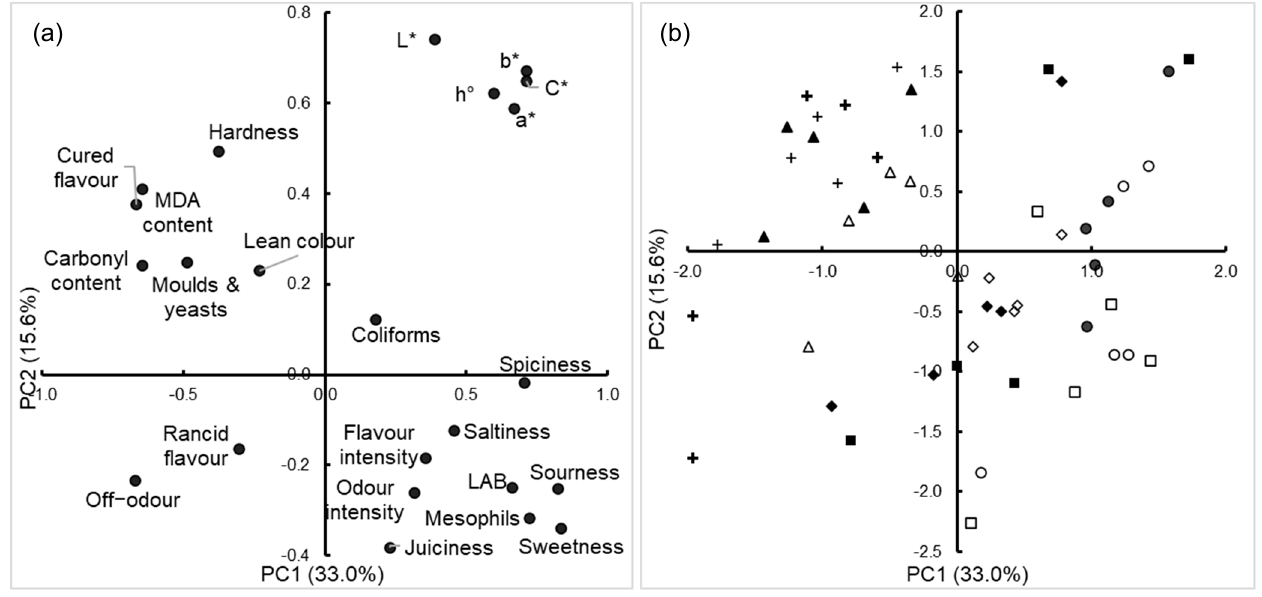
Figure 1. Projection of the variables ( a ) and samples ( b ) onto the space defined by the first two principal components (PC1/PC2) extracted from the variables in Tables 2,4 and 5. b) ○ : Control, day